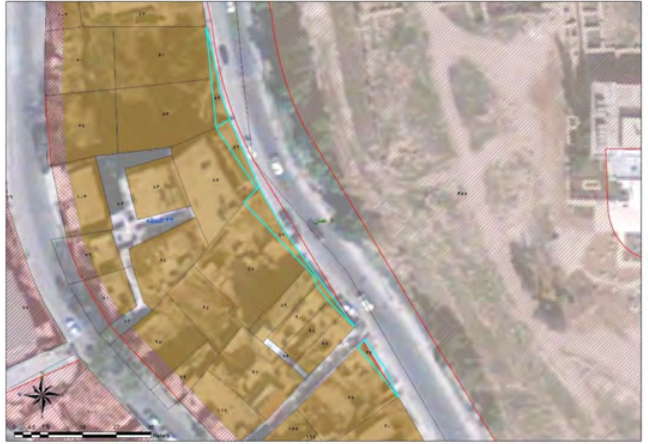
Figure 4. Land bit land-use over aerial view map. Source: GAM- GIS for the author